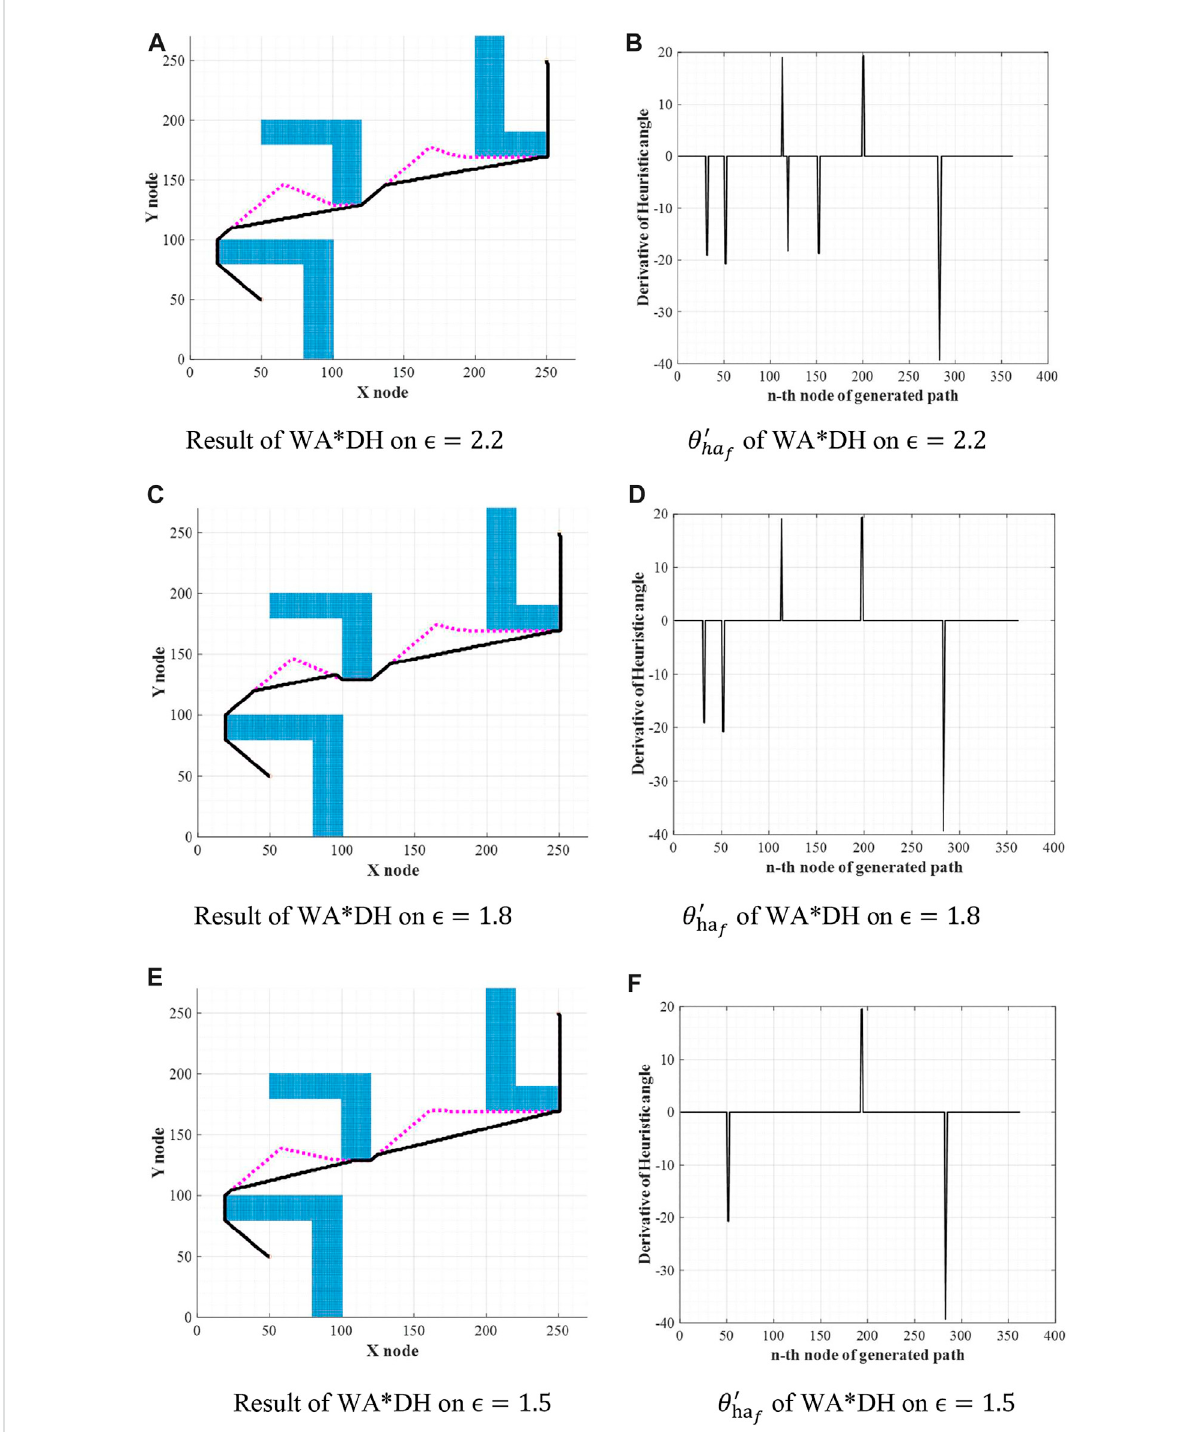
FIGURE 6 ResultsofWA*DHonthedifferentin fl ationfactors. (A) ResultofWA*DHon ϵ (cid:2) 2 . 2. (B) θ ′ ha f ofWA*DHon ϵ (cid:2) 2 . 2. (C) ResultofWA*DHon ϵ (cid:2) 1 . 8. (D) θ ′ ha f of WA*DH on ϵ (cid:2) 1 . 8. (E) Result of WA*DH on ϵ (cid:2) 1 . 5. (F) θ ′ ha f of WA*DH on ϵ (cid:2) 1 .